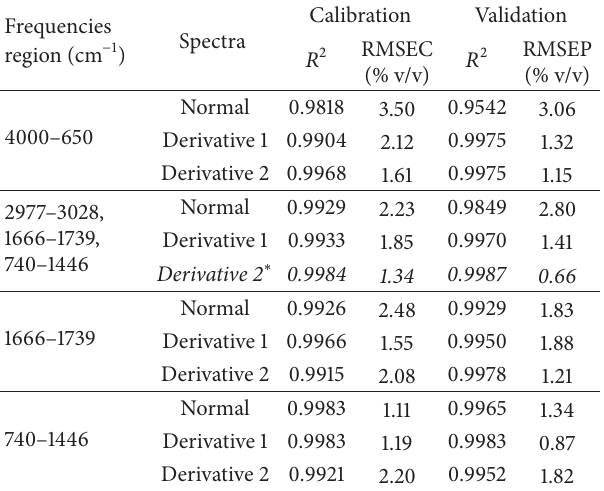
Table 4: PLS performances at some frequency regions for the determination of NSO in binary mixtures with